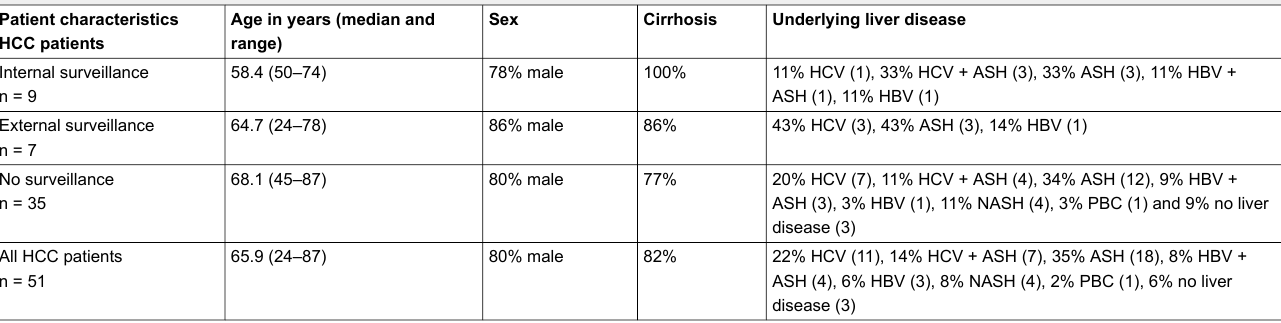
Table 2: Patient characteristics (age, sex, cirrhosis and underlying liver disease) of internally surveyed, externally surveyed and not surveyed HCC patients. Patient characteristics HCC